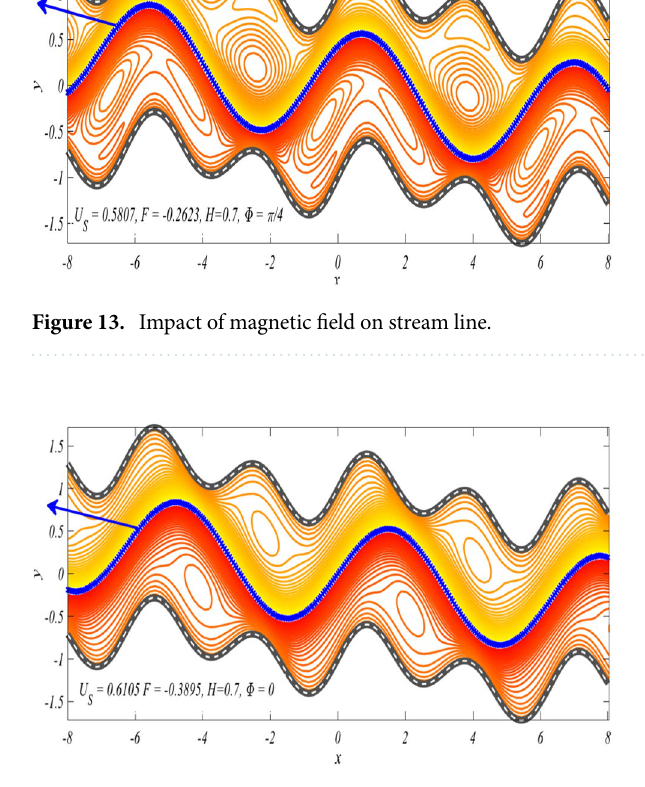
Figure 14. Impact of phase difference on stream line.